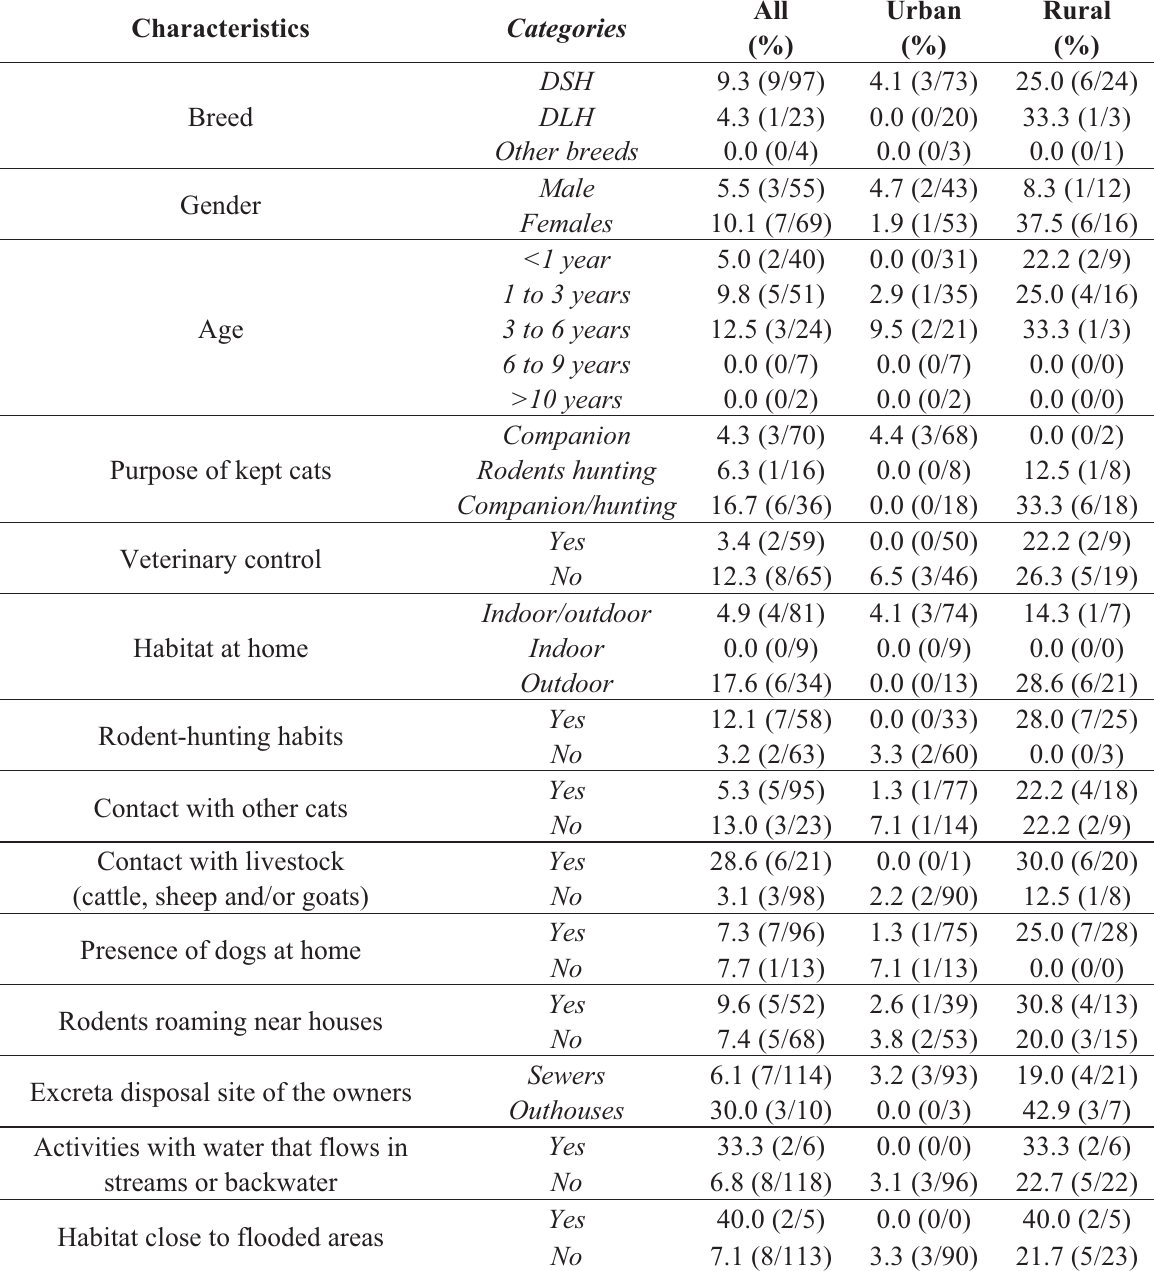
Table 4. Prevalence of anti- Leptospira antibodies based on MAT results according to individual, lifestyle and habitat characteristics of cats from different